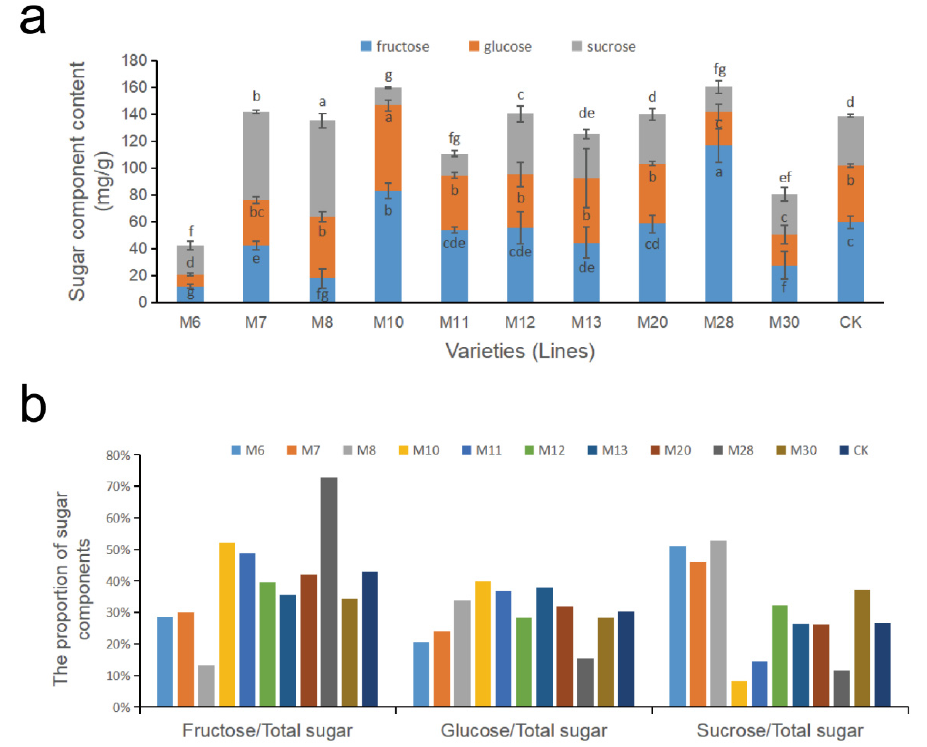
Figure 3. Changes in soluble sugar components ( a ) and the proportion of sugar components ( b ) in wild A. eriantha varieties (lines) at the ripening stage. The different letters shown in ( a ) indicate significant differences ( p < 0.05), and the same letters indicate no significant difference ( p > 0.05).